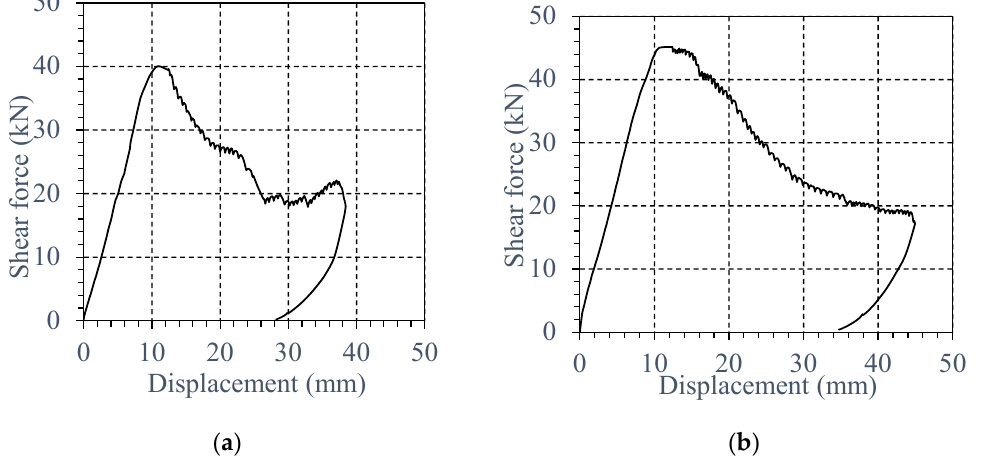
Figure 16. Shear force–deflection diagrams for specimens. ( a ) DR-R ; ( b ) CCRS-R .